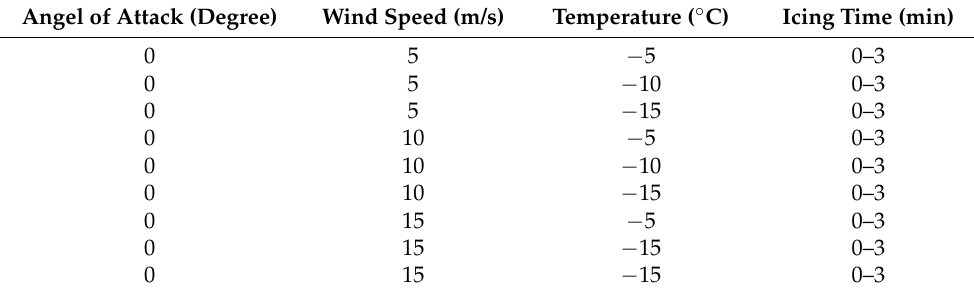
Table 3. Test conditions of the icing wind tunnel